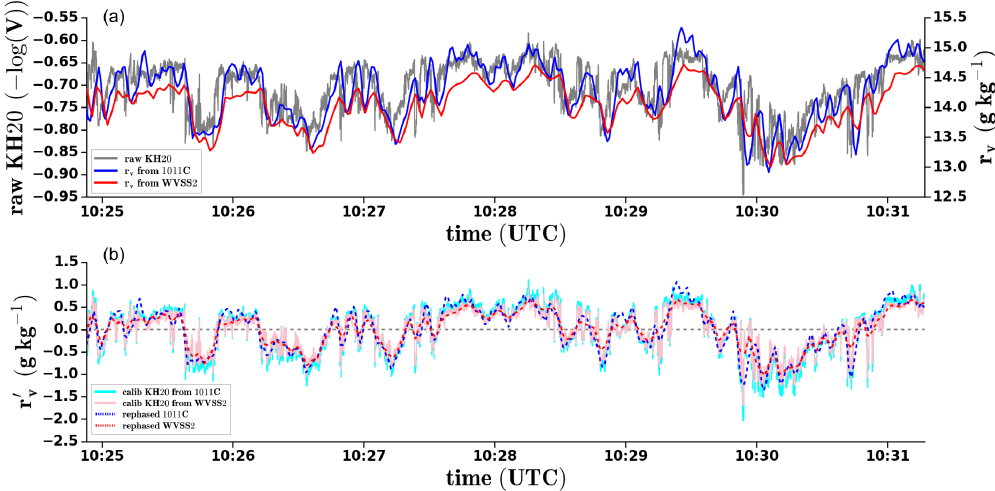
Figure 2. Example of humidity measurements and calibration during a leg (l1a) flown at z ∼ 600m on 13 February 2020 (RF19): (a) time series of (gray line) the raw uncalibrated signal of the fast KH20 sensor and the water vapor mixing ratio inferred from (blue line) the 1011C mirror hygrometer or (red line) the WVSS2 sensor. (b) Corresponding time series of the water vapor mixing ratio fast fluctuations derived from the KH20 calibrated signal and the reference slow measurements phased in time with the fast sensor from (cyan line) the 1011C mirror hygrometer and (pink line) the WVSS2 sensor.